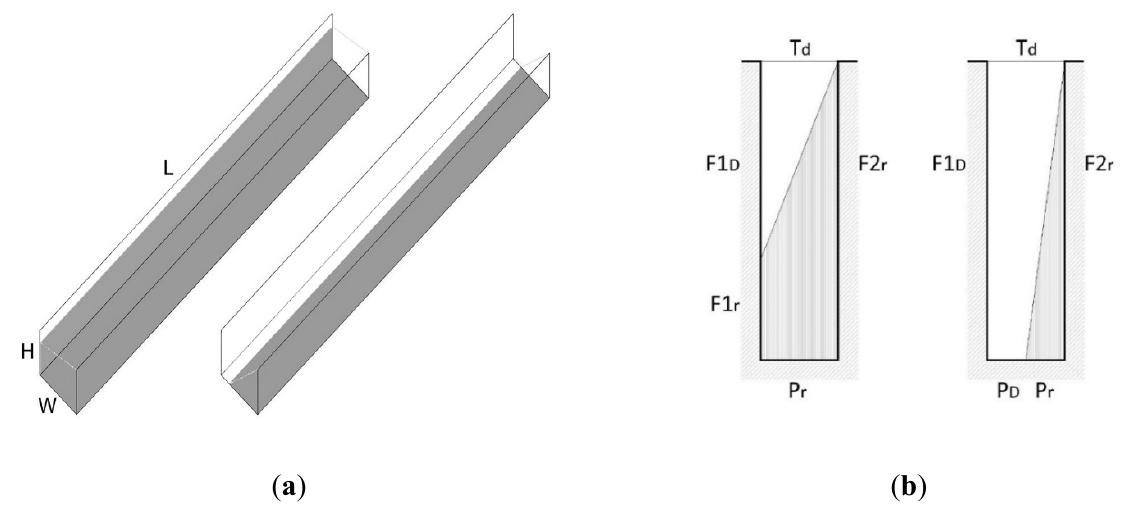
Figure 4. ( a ) Urban canyon model; ( b ) Lighting hypothesis within urban canyon.